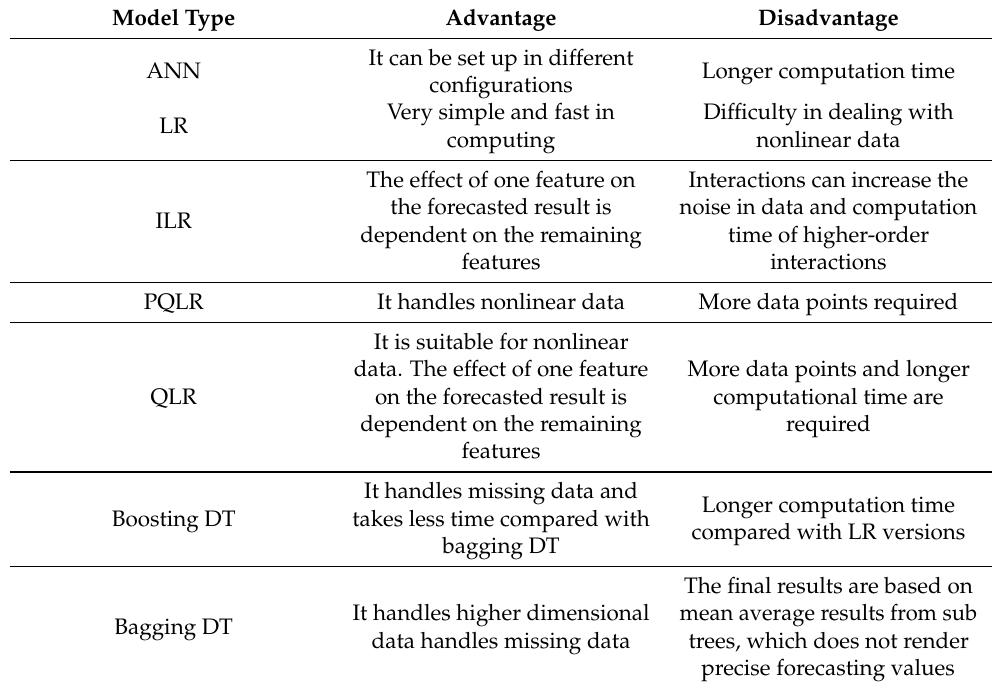
Table 15. Approximation of comparison of the used